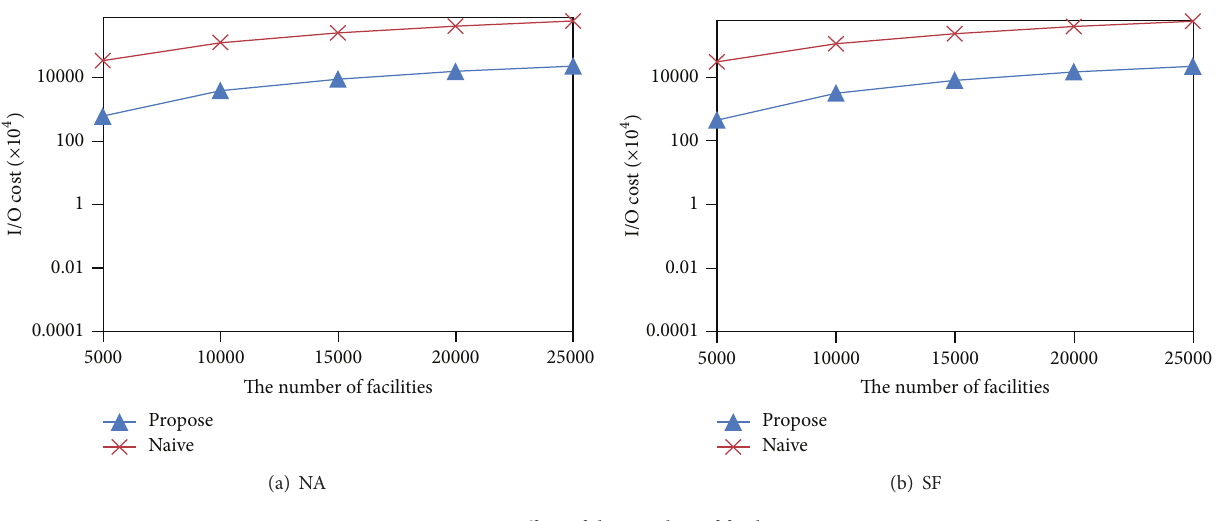
Figure 13: Effect of the number of